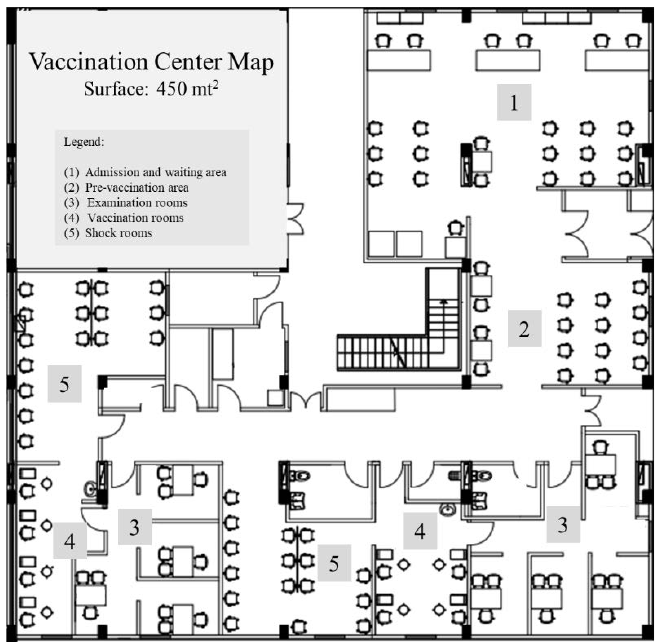
Figure 1. Vaccination Center (VC) map.